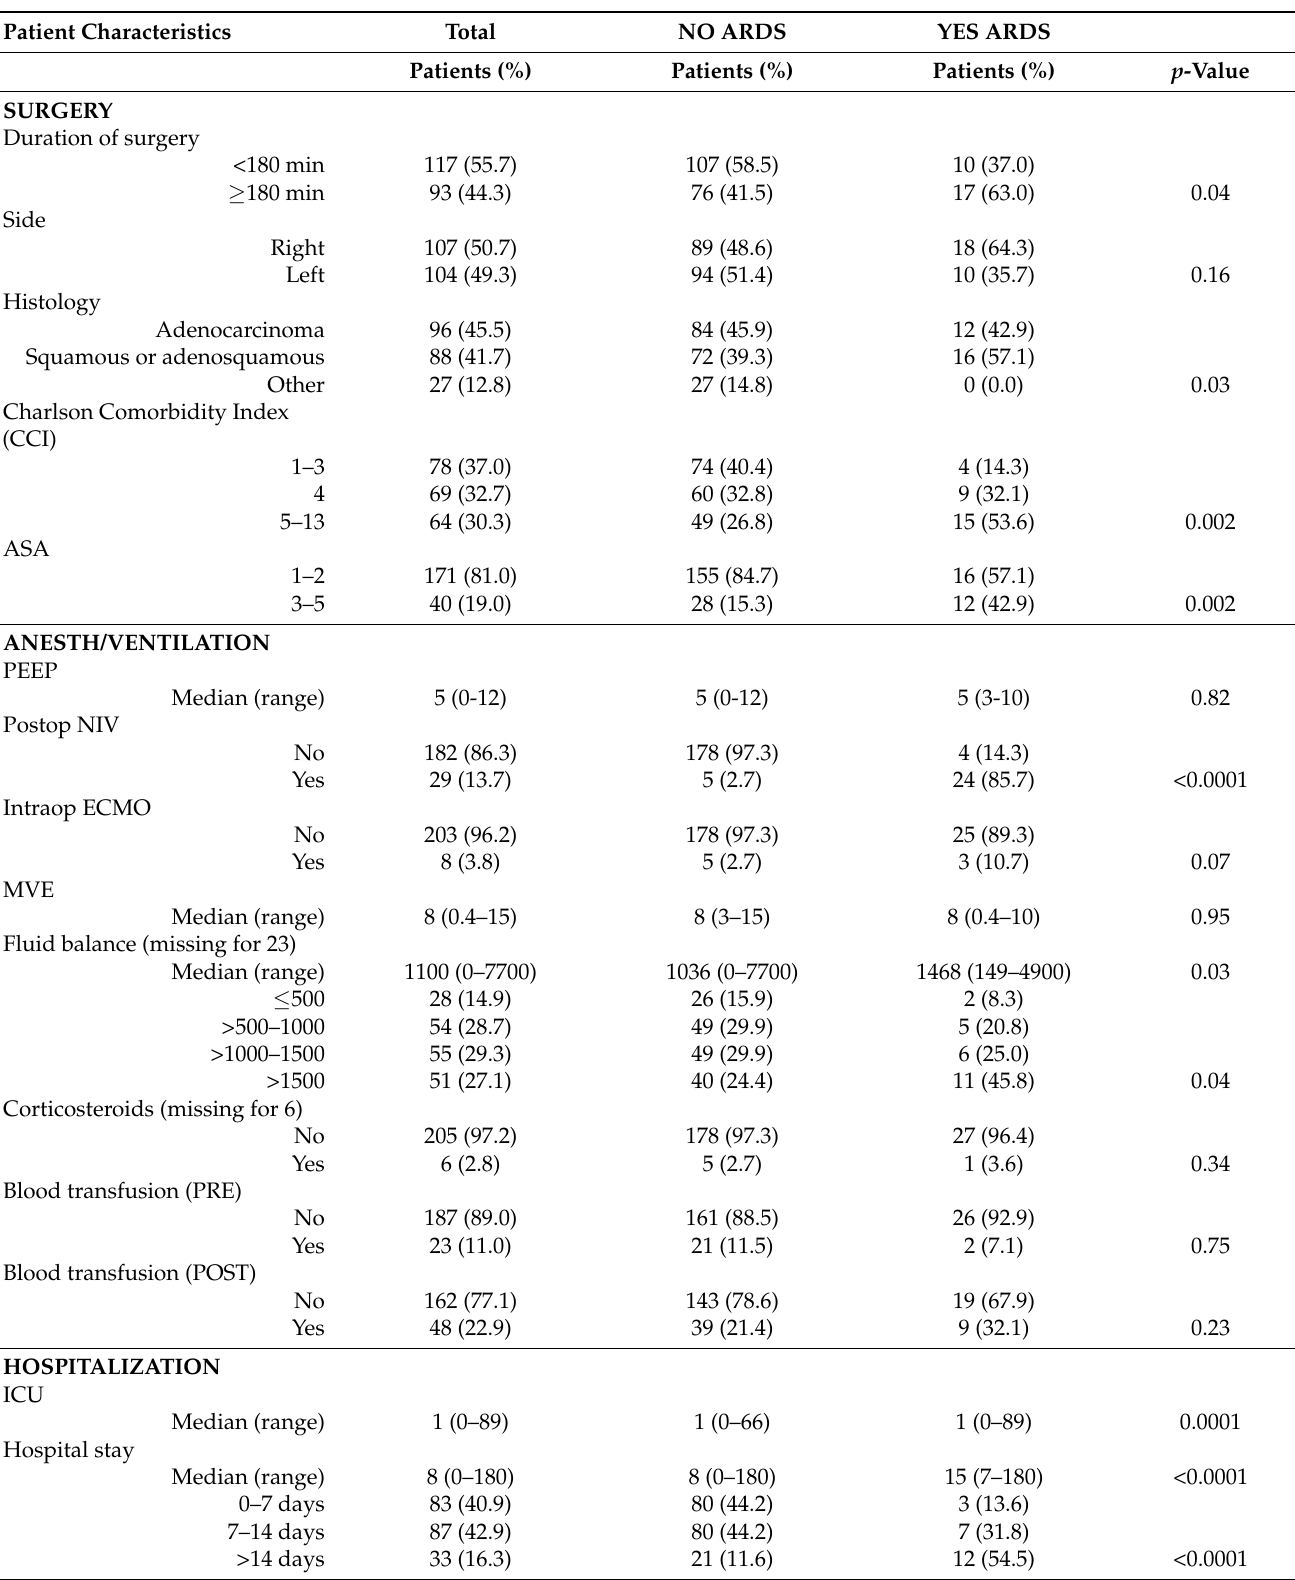
Table 3. Peri- and postoperative factors associated with development of